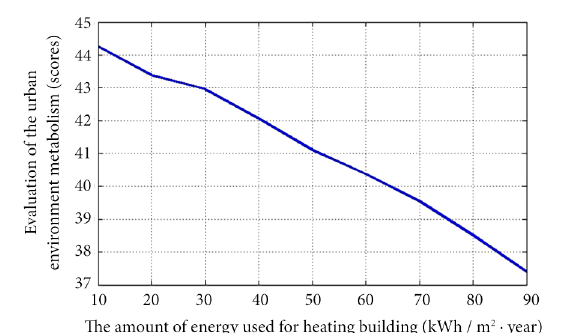
Figure 7. Dependence of the urban environment metabolism Poltava city from the amount solid household waste